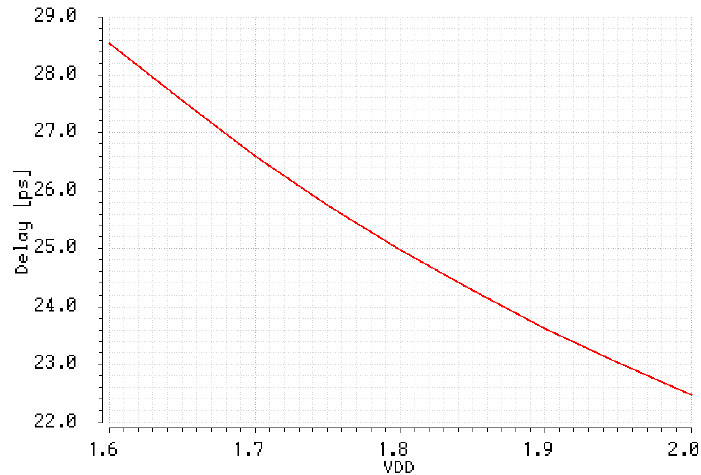
Figure 42. Unit delay vs. voltage supply.